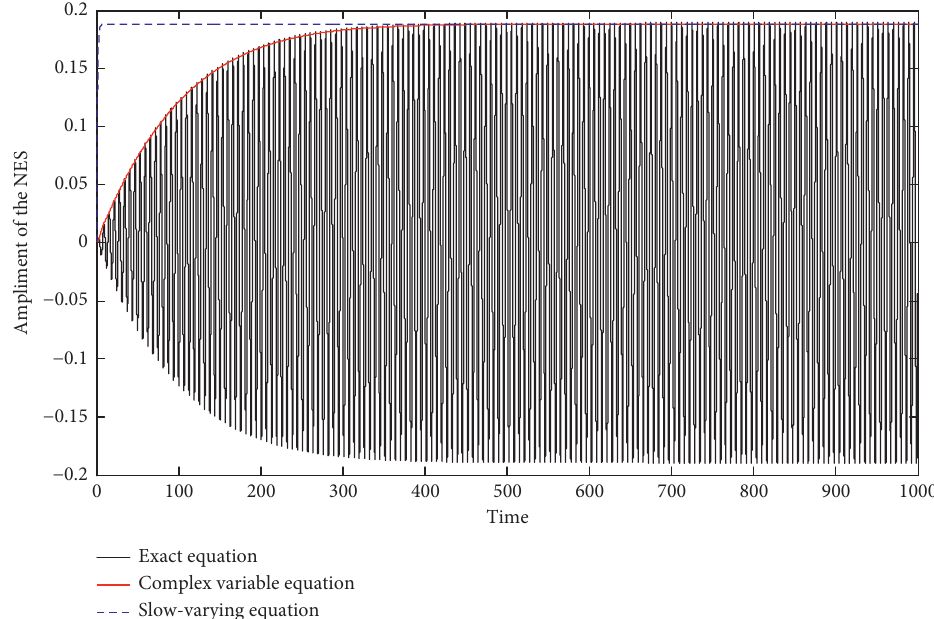
Figure 15: Time-history curves of nonlinear energy sink. The dashed line refers to the steady-state response of the slow-varying equation ( f � 0 . 2).